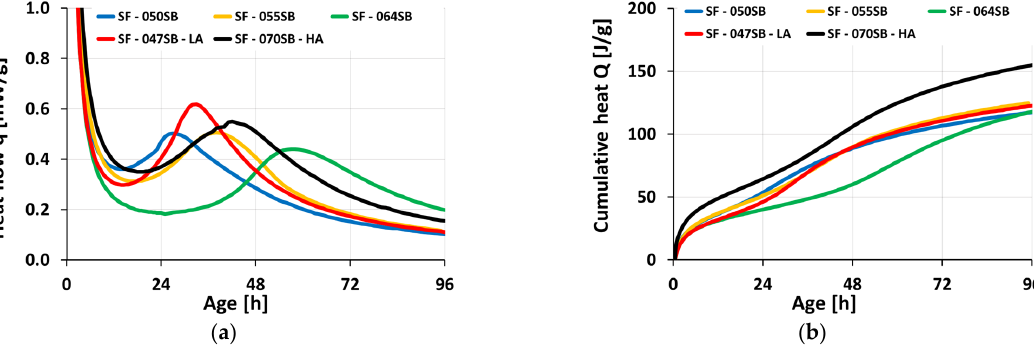
Figure 4. Isothermal calorimetry as a function of age: ( a ) heat flow; ( b ) cumulative heat release.